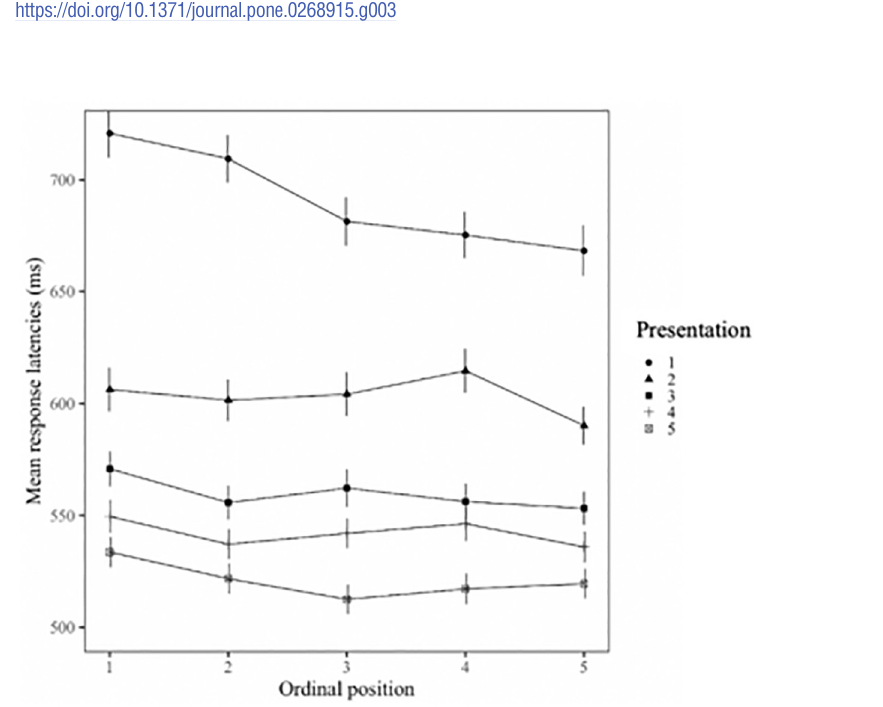
Fig 4. Visual representation of the facilitation effect in all five presentations.